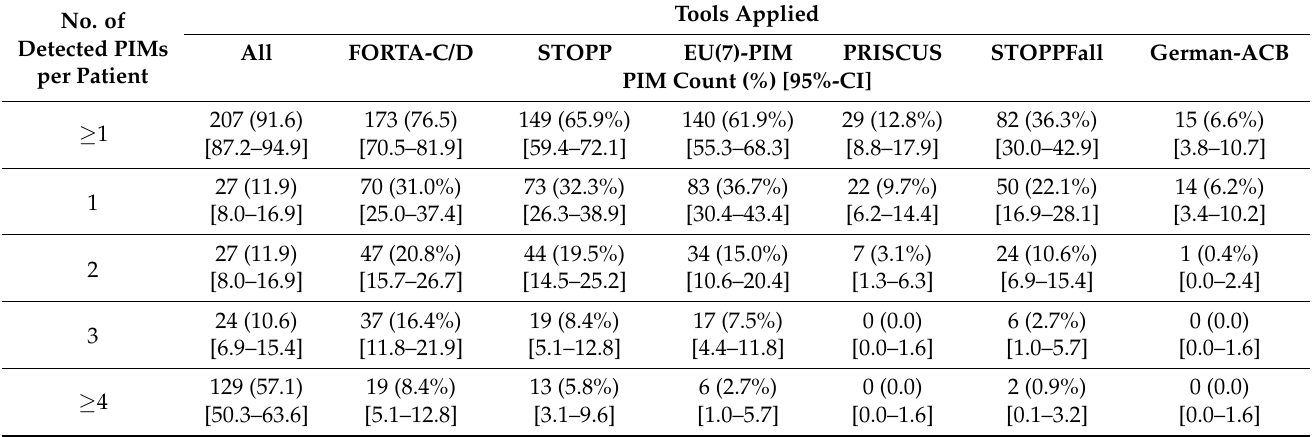
Table 3. Prevalence of potentially inappropriate medication (PIM) within the study population ( n =